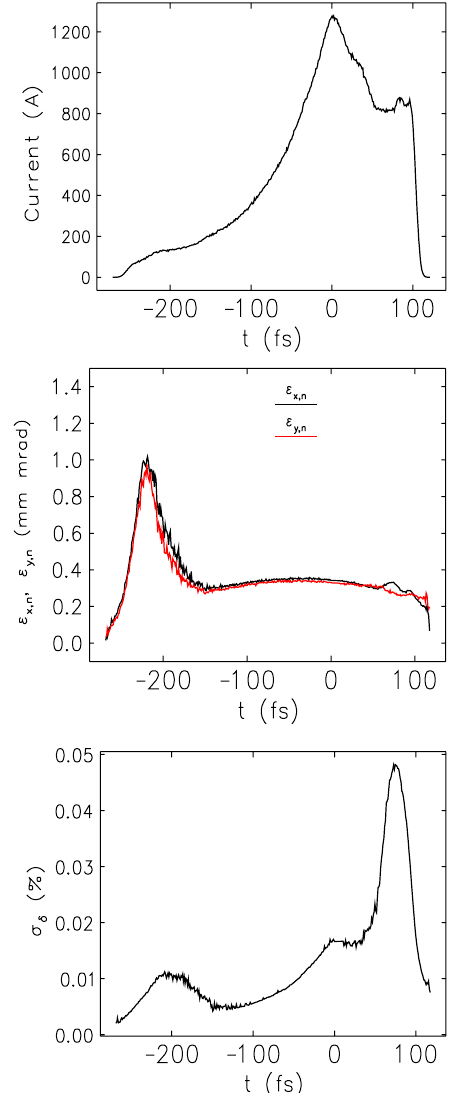
FIG. 13. Bunch properties on entrance to FEL in 1 fs slices: top—current profile; middle—slice emittance; bottom—slice energy spread.